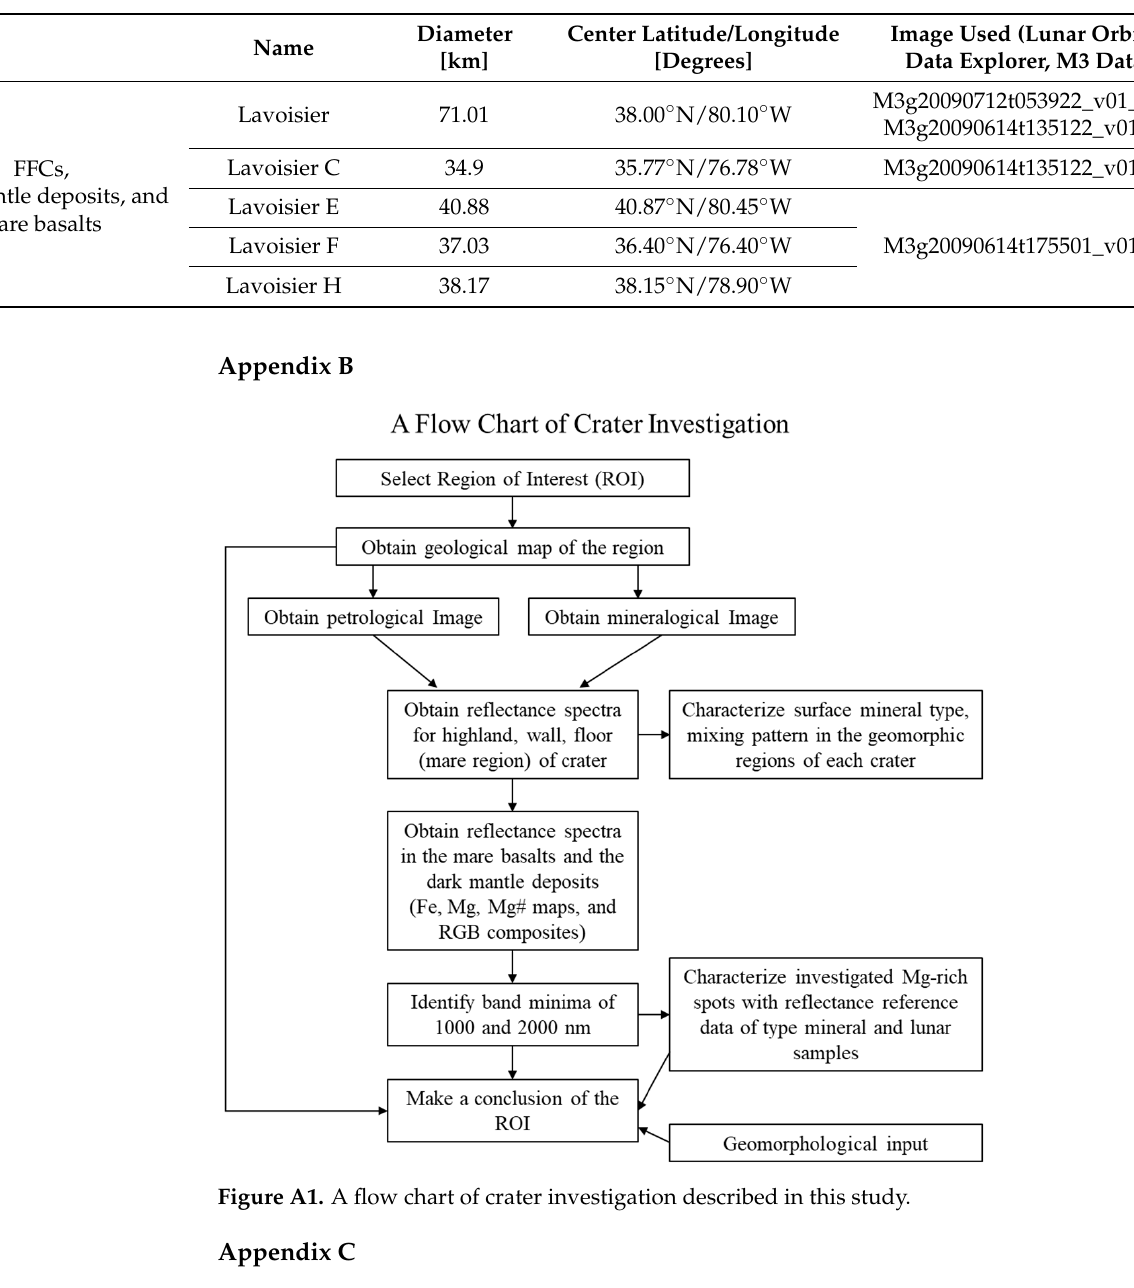
Table A2. The location for each spectrum from Figure 5 to Figure 8 (the data were downloaded